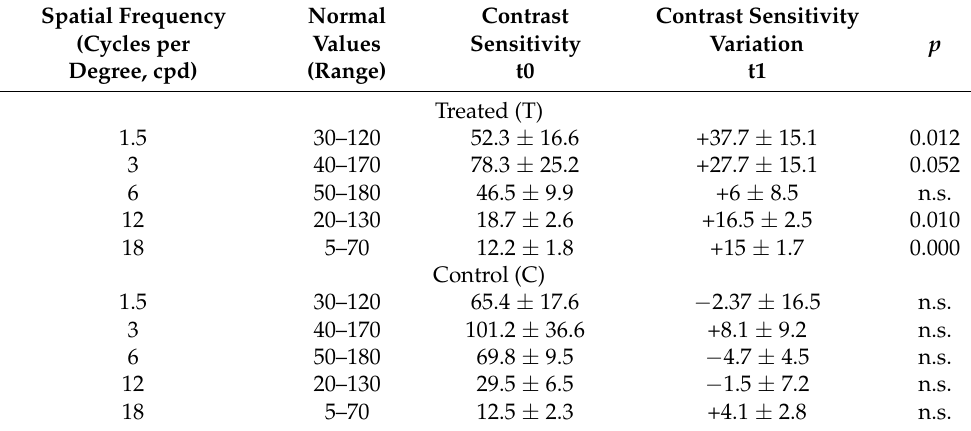
Table 2. Contrast sensitivity changes over one month period in subjects receiving a tablet a day of Meramirt CM (treated, T) and in a control group (control, C). (+ = improved examination; − = worsened